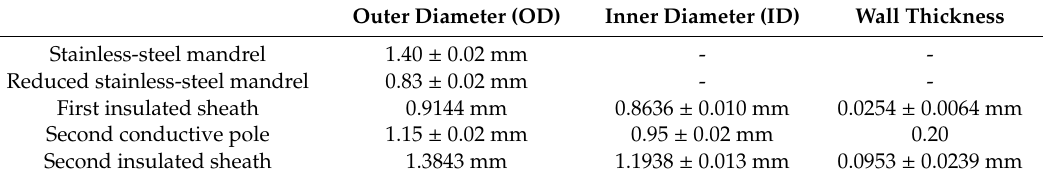
Table 7. Characterization of components used to make the electrode